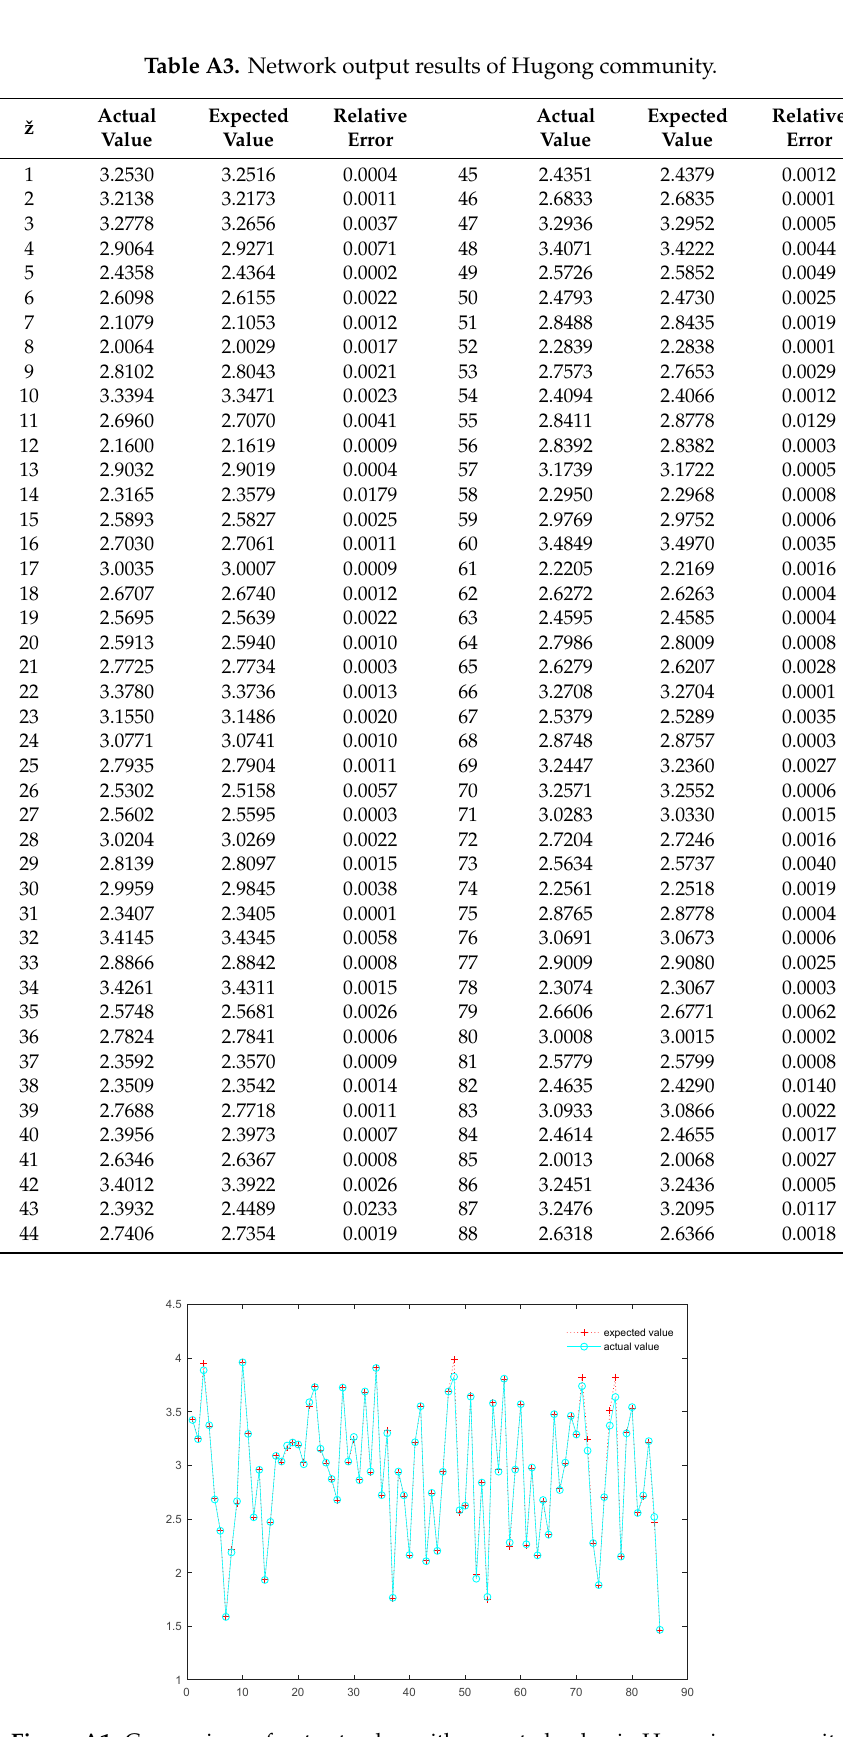
Figure A1. Comparison of output value with expected value in Hongxia community.